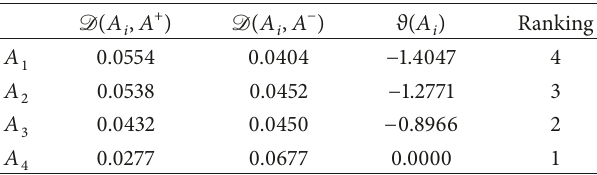
Table 6: The revised closeness of suppliers and the ranking order of